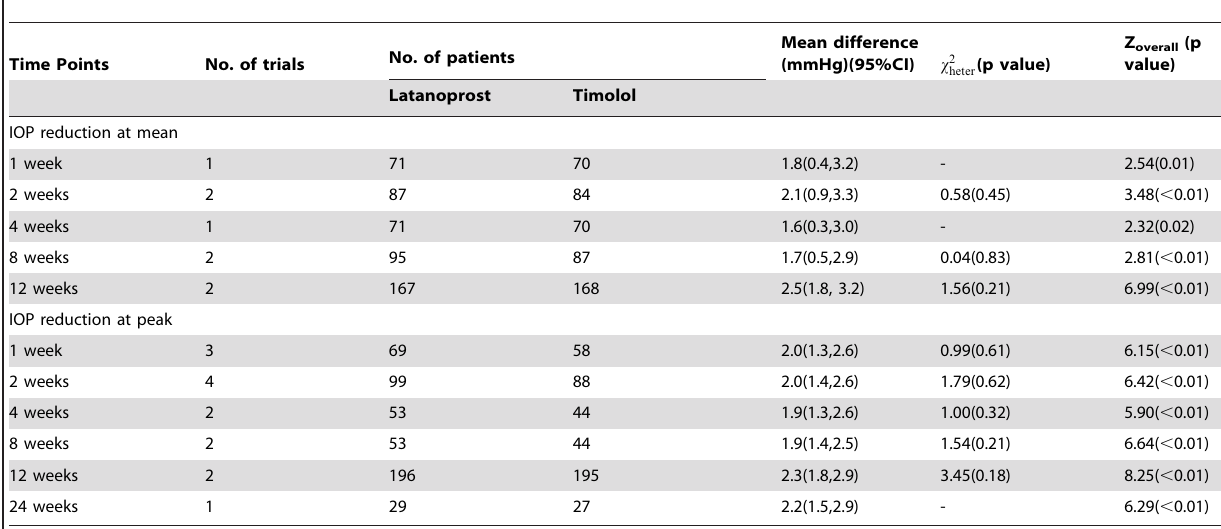
Table 3. Absolute IOP reduction from baseline at different time